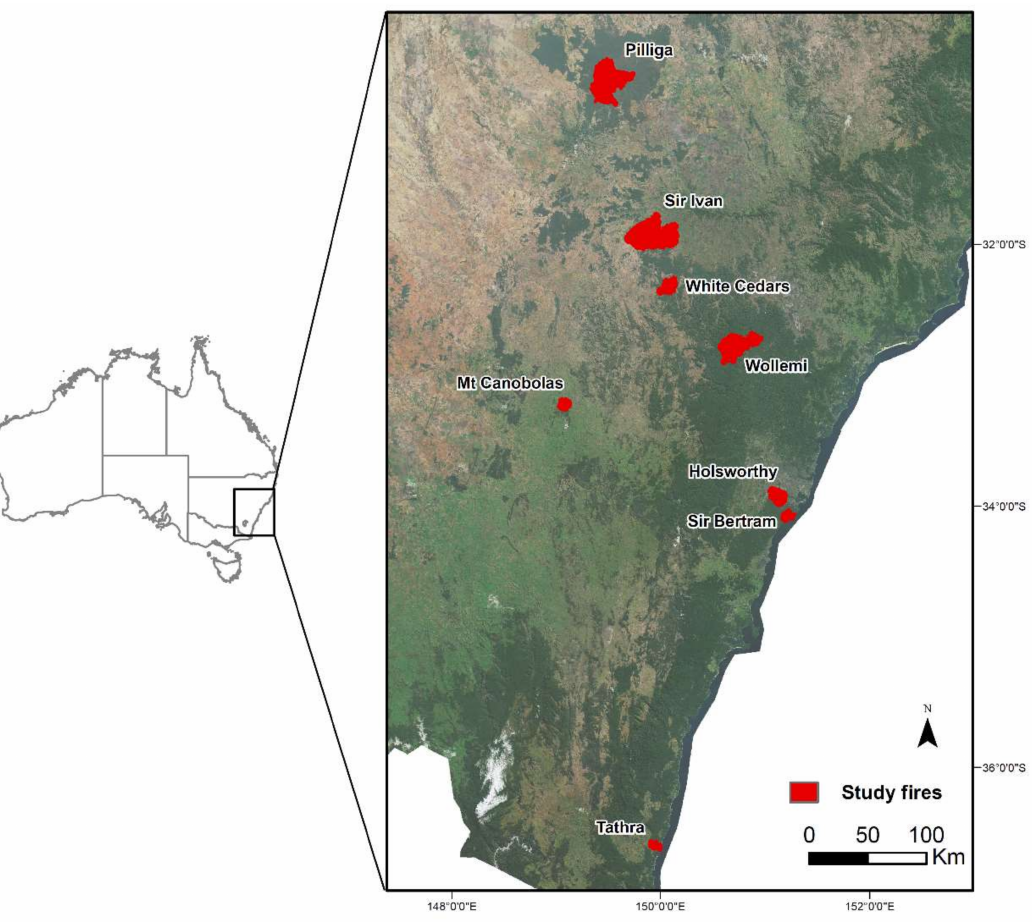
Figure 2. Location and relative size of the eight training fires used in accuracy assessments in New South Wales,